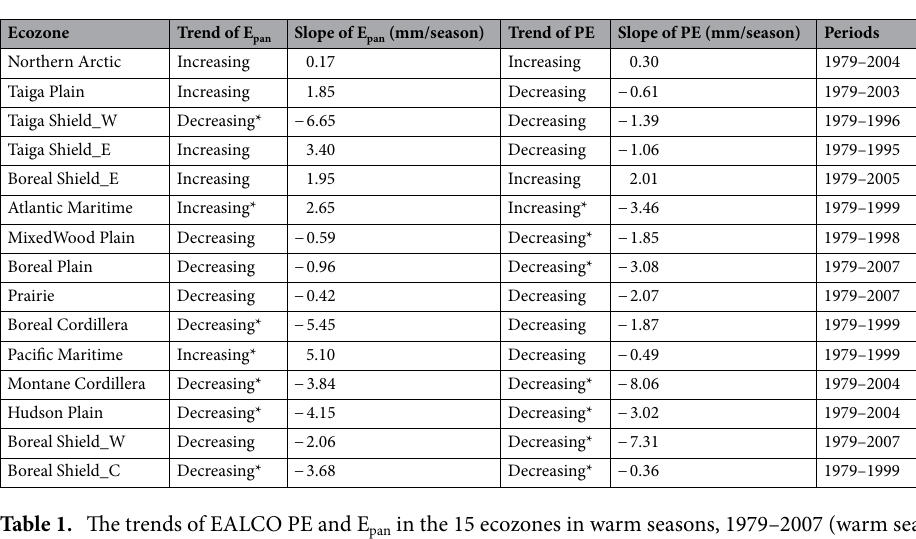
Table 1. The trends of EALCO PE and E pan in the 15 ecozones in warm seasons, 1979–2007 (warm seasons refer to June–September in Northern Arctic and May–September in the other ecoregions, respectively, and * indicates the trend is significant at the 95% confidence interval).